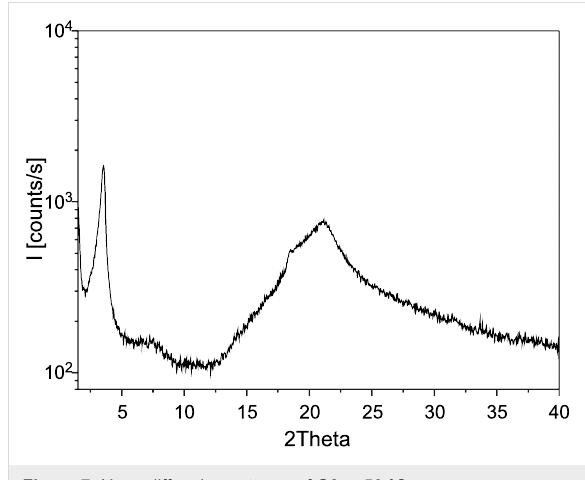
Figure 7: X-ray diffraction patterns of G3 at 50 °C.